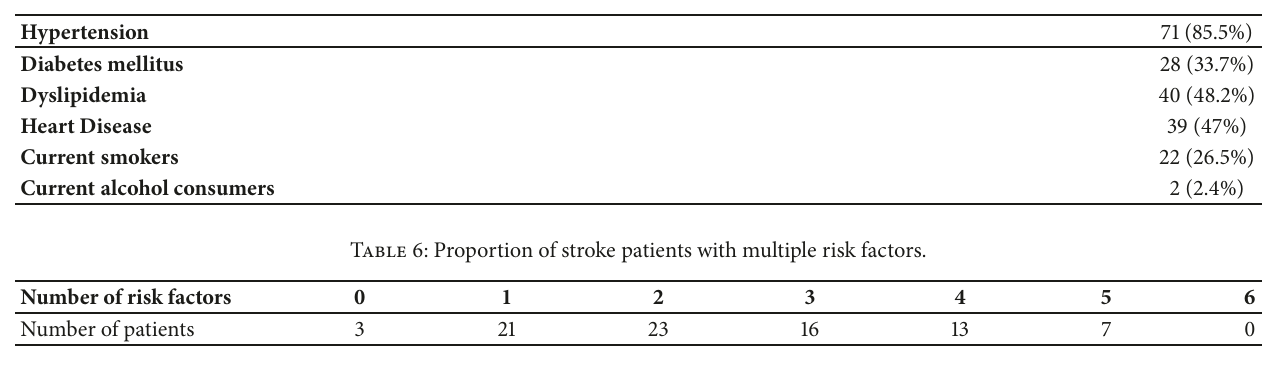
Table 5: Risk factors of stroke patients.